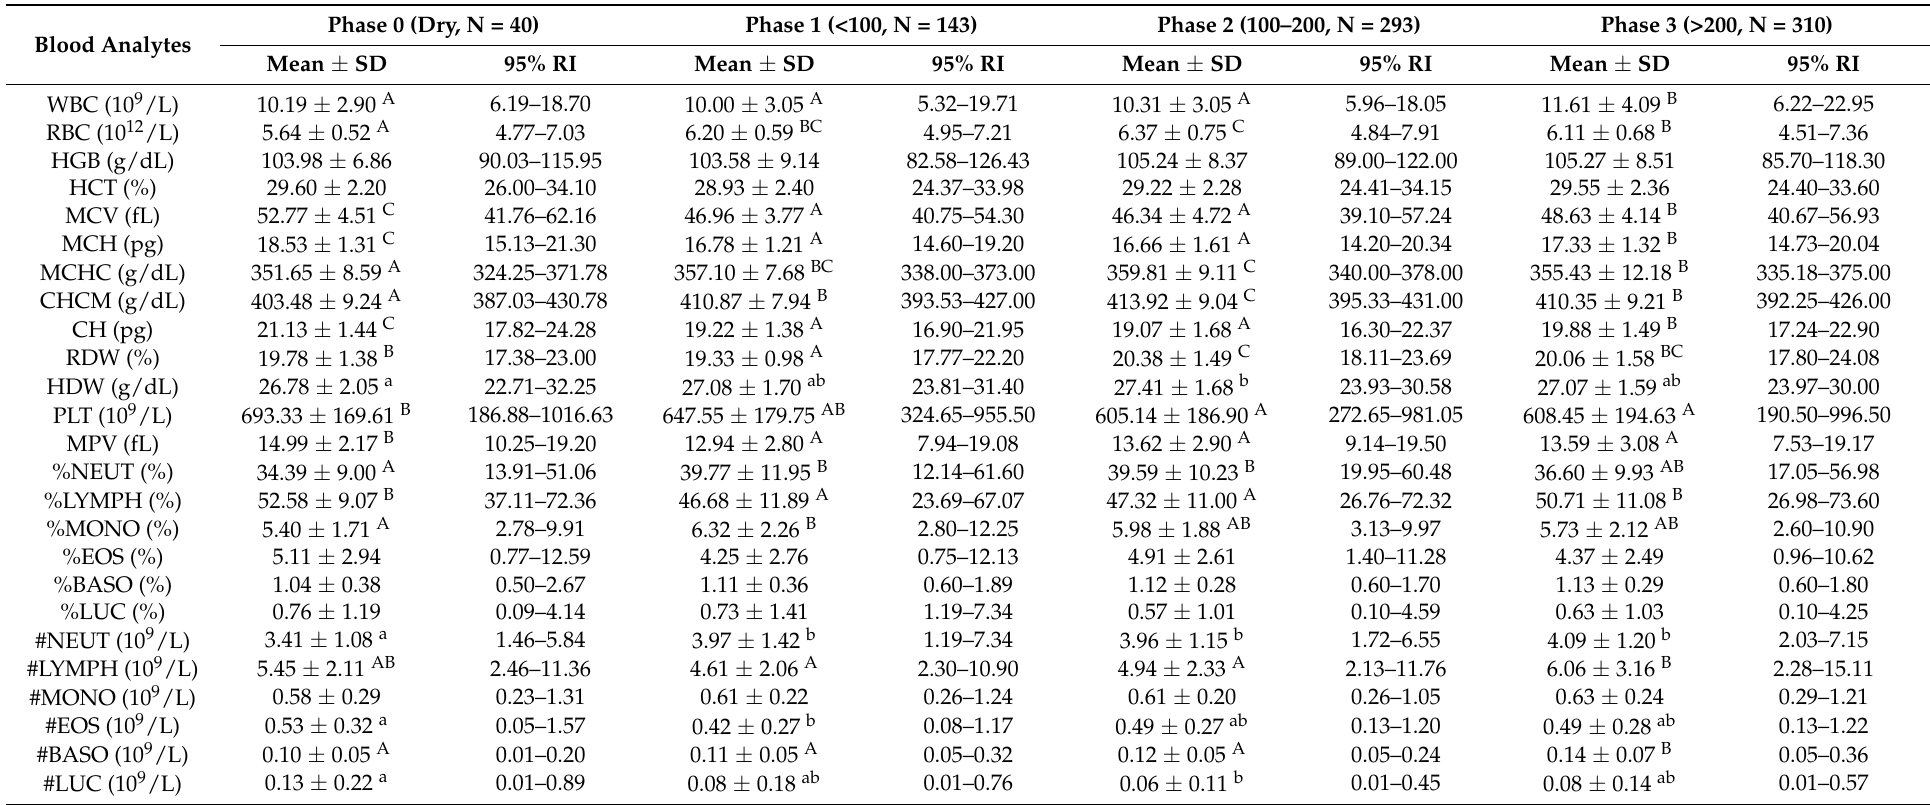
Table 4. Hematology values and RIs for Holstein cows at different lactation